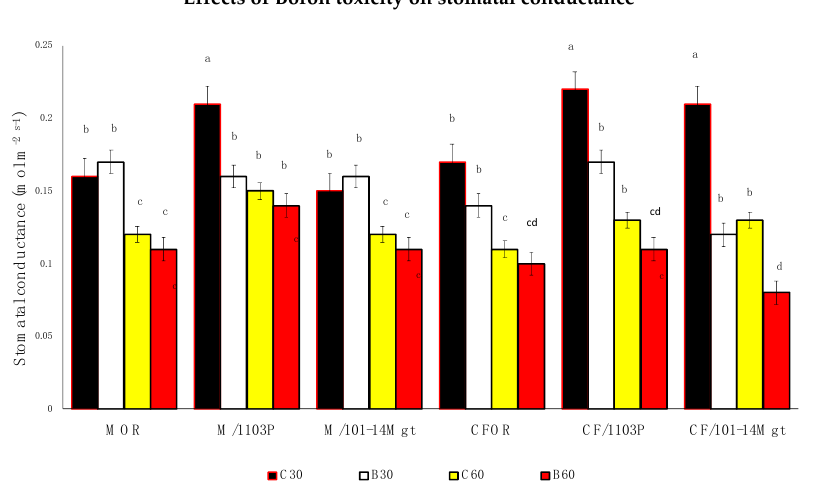
Figure 5. Net CO 2 assimilation rate ( a ) and stomatal conductance ( b ) of Merlot (M) and Cabernet Franc (CF) grapevine cultivars on their own roots (OR) and on 1103P and 101-14 Mgt rootstocks, thirty and sixty days after the start of boron treatments. C represents the control treatment; B represents the boron treatment. 30, 60 (at day thirty and sixty, respectively). Different letters represent significant differences at p < 0.05.